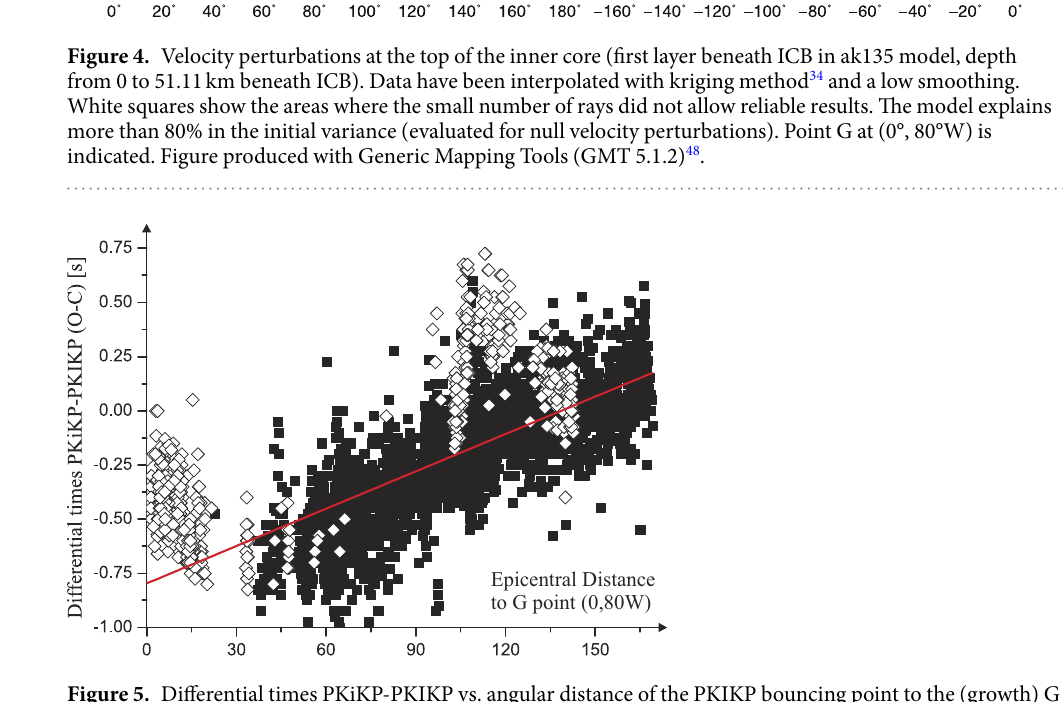
Figure 5. Differential times PKiKP-PKIKP vs. angular distance of the PKIKP bouncing point to the (growth) G point (0, 80°W). Significant departures from the regression line can be observed near 15° or 120° distances due to some of the observations related mainly to some South Sandwich earthquakes (white diamonds). R-square value is